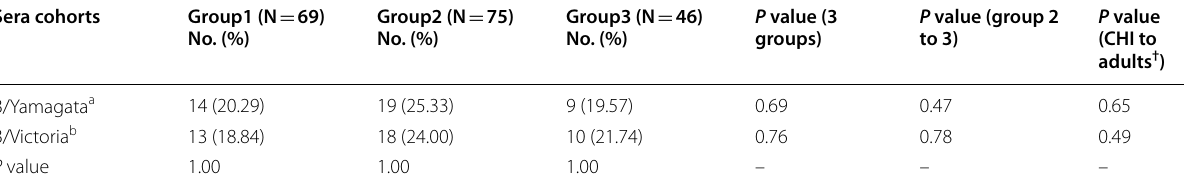
The percentages were estimated as a fraction of total cases belonging to each category. P values were estimated using χ 2 tests or Fisher’s exact tests (between B/Y and B/V of each group) † CHI: summary of group 2 and group 3 to represent samples from children. Adults: samples from adult in group 1 a B/Beijing/BTCH_71/2018 was used as antigen representative of B/Yamagata lineage virus b